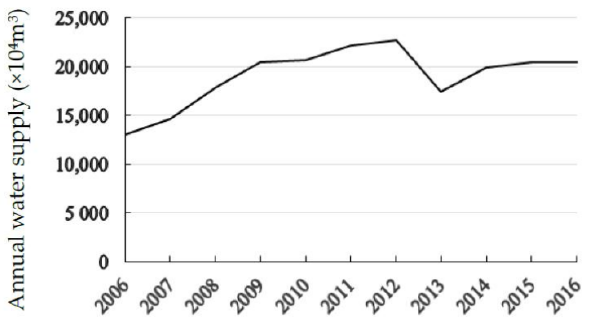
Figure 3. Surface water inflow of the Hongyashan irrigation district (HYS) from 2006 to 2016.